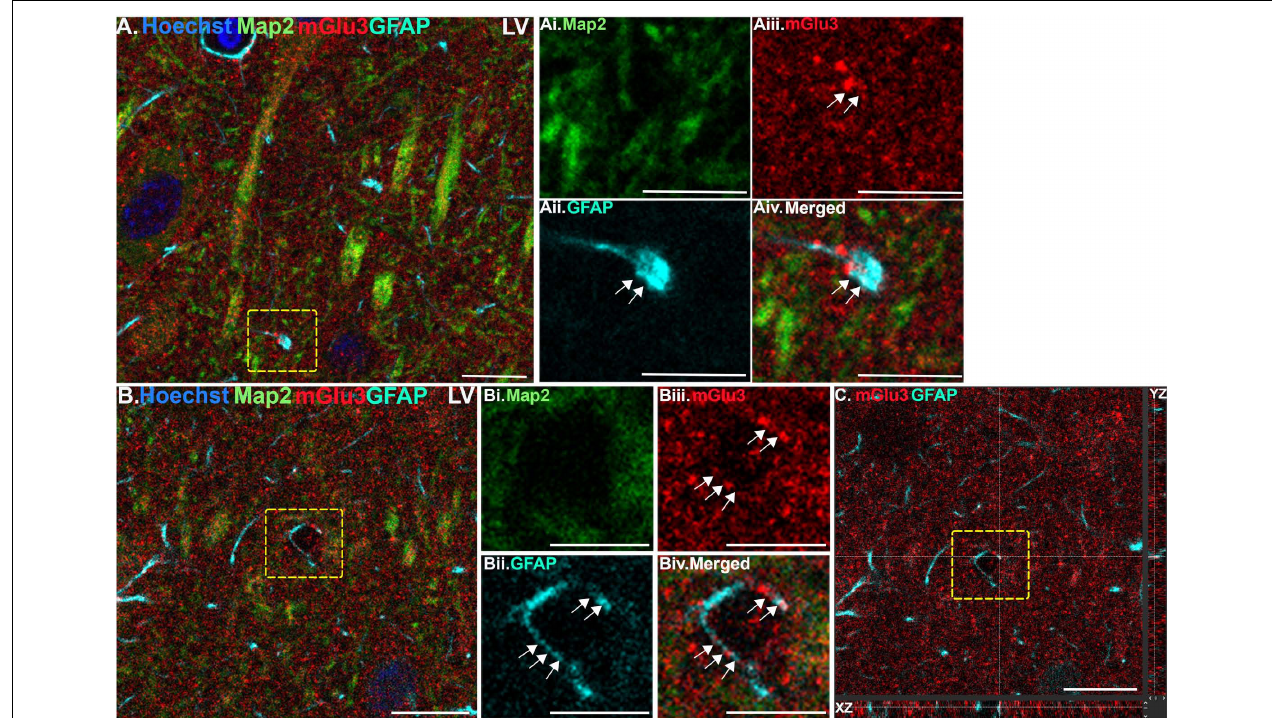
FIGURE 2 | Multiple label immunofluorescence of mGlu3 labeling in astrocytes in layer V of rat PL mPFC. Tissue was labeled with antibodies recognizing the astrocytic protein GFAP (cyan), mGlu3 (red), the dendritic marker Map2 (green), as well as the nuclear Hoechst stain (blue). (A) Expression of mGlu3 in the neuropil of Layer V is evident. There is GFAP positive astrocytic process that contains mGlu3 labeling. (Ai–iv) Magnified area of the region outlined by the yellow box in (A) showing co-localization of mGlu3 (red) and GFAP (cyan) within a bulbous end of a process, without the presence of Map2 (green). (B) This is an example of a GFAP positive astrocytic process overlying likely a blood vessel. (Bi–iv) Magnified area of the yellow box in (B) showing co-localization of mGlu3 and GFAP in a Map2 negative region. (C) Orthogonal sectioning of this region (corresponding region of interest from (B) outlined by the yellow box). Selected z-stack image shows co-localization of mGlu3 and GFAP (red and cyan) across three different planes for one point, as indicated by the crossed dashed lines. The right-side bar demonstrates labeling in the YZ plane, while the bottom bar represents labeling in the XZ plane. Scale bars: 10 µ m (A,B) ; 5 µ m (Ai–iv,Bi–iv) ; 10 µ m (C)